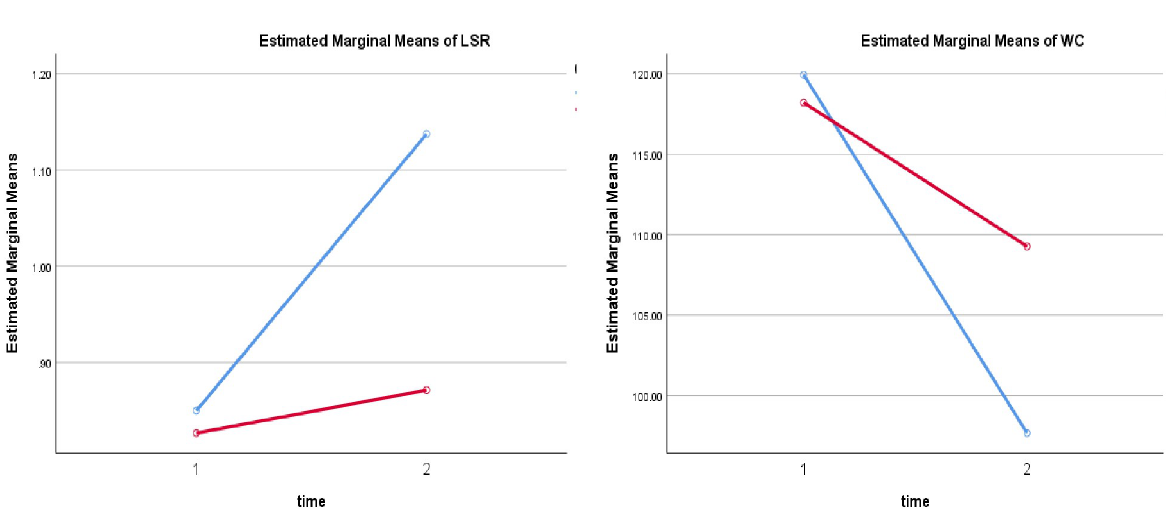
Fig 2. Liver/spleen ratio (LSR) and waist circumference (WC) in the two groups pre- &